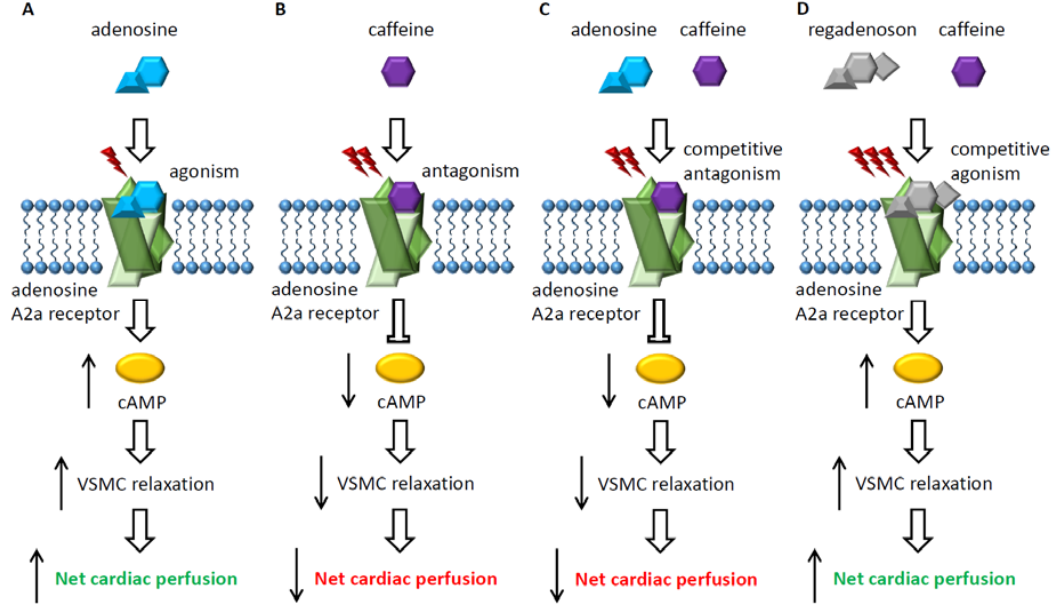
Figure 1. Suggested molecular A 2a -receptor effects showing adenosine agonism ( A ), caffeine antagonism ( B ), competitive antagonism of caffeine on adenosine ( C ), and competitive agonism of regadenoson on caffeine ( D ).